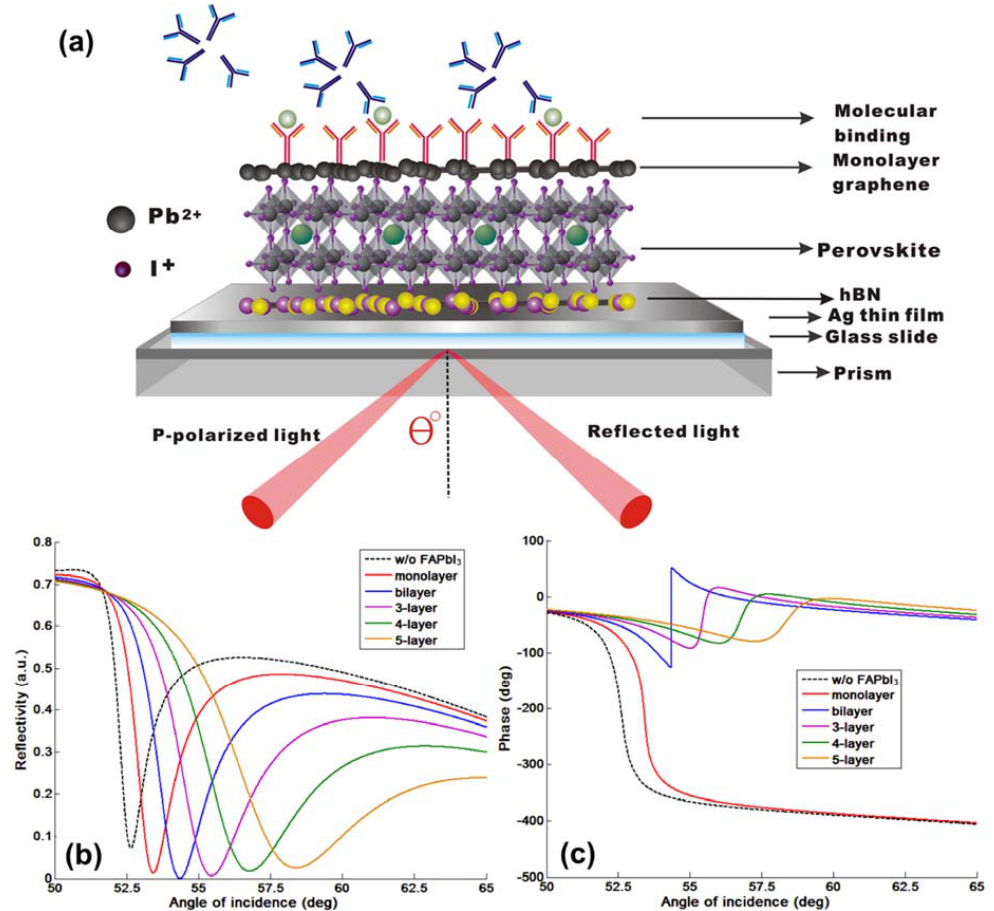
Figure 2. ( a ) Schematic figure of 2D perovskite-based GH-SPR biosensor with continuous silver substrate. SPR curves with reflectivity ( b ) and phase ( c ) signal changes with different numbers of layers of 2D perovskites (FAPbI 3 ) engineered on top of the continuous silver substrate at 604 nm.